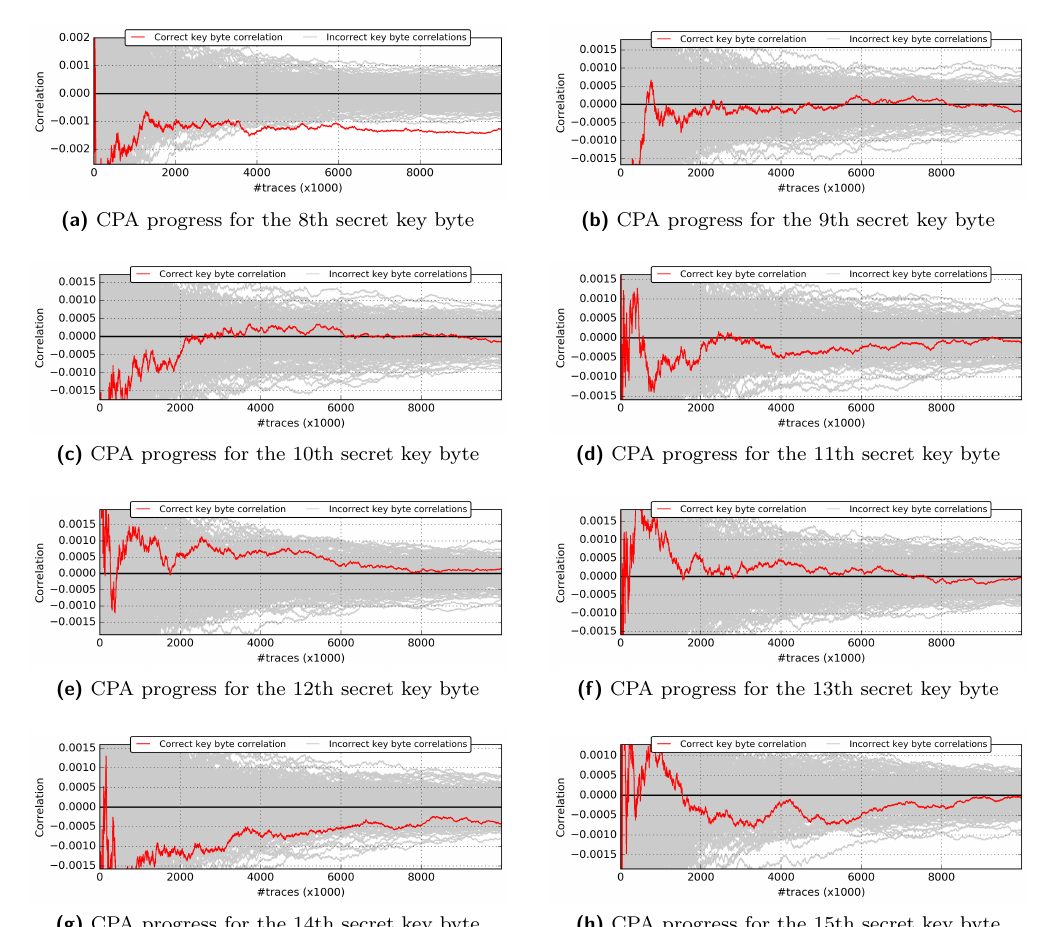
Figure 22: Results of a CPA attack on the last secret round key (bytes 8 to 15) of AES on the STM32F407VG Discovery #1 @168MHz with the ADC connected to GND and the program compiled with the -Os optimization option. Each plot shows the correlation progress of all 256 key candidates for a specific key byte over 10 M traces and the respective correct key candidate is marked